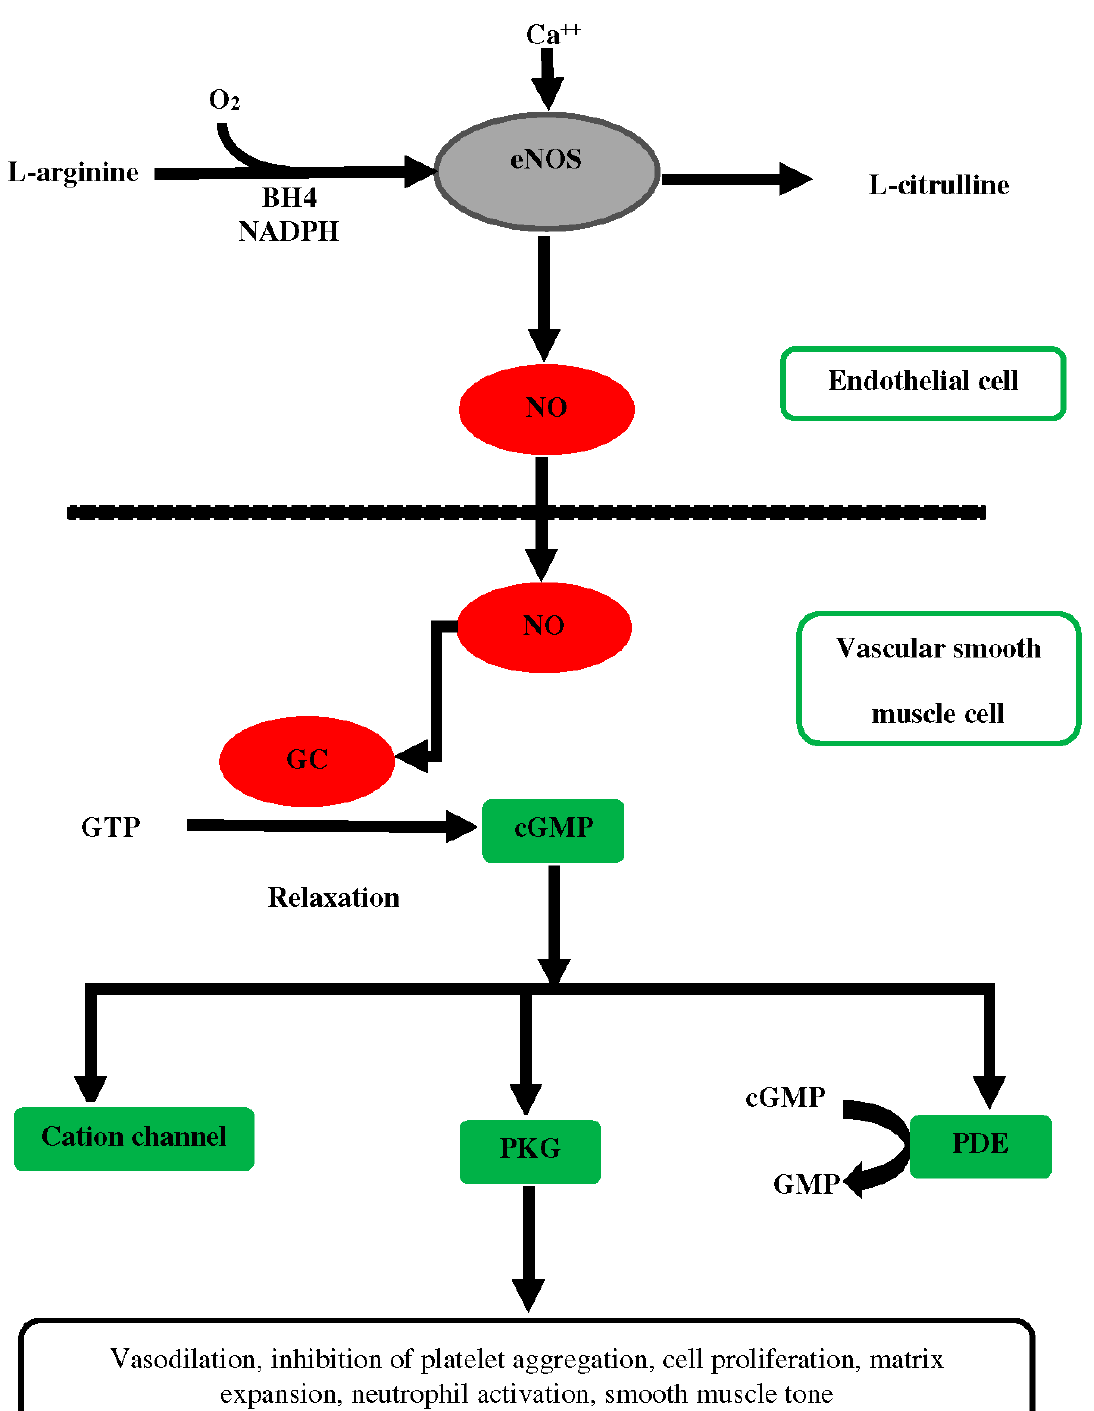
Figure 1. Synthesis of nitric oxide from precursor L -arginine in endothelial cells and mechanism of vasodilation in vascular smooth muscle.